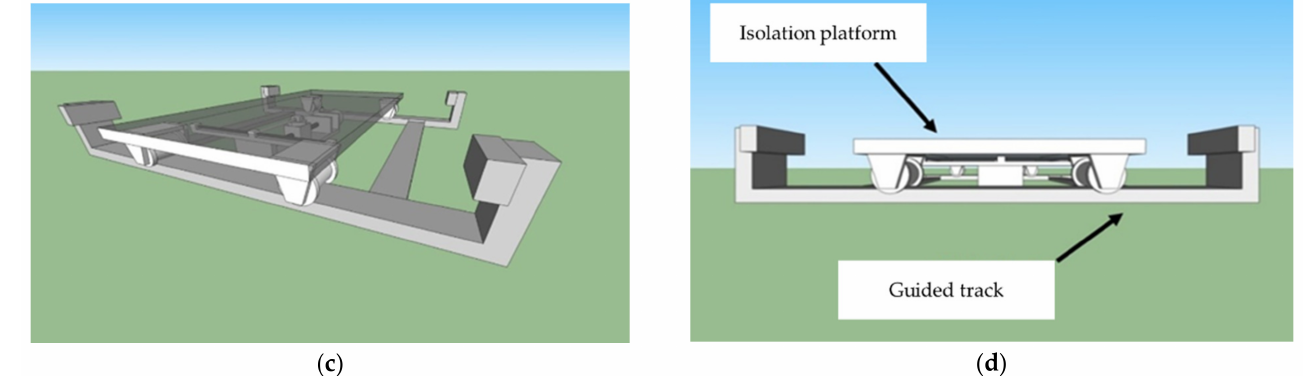
Figure 1. Schematic diagram of LSCIS isolation system. ( a ) Physical model of the LSCIS isolation system. ( b ) Mathematical model of the LSCIS isolation system. ( c ) Drawing of the LSCIS in 3D. ( d ) Side view of the LSCIS